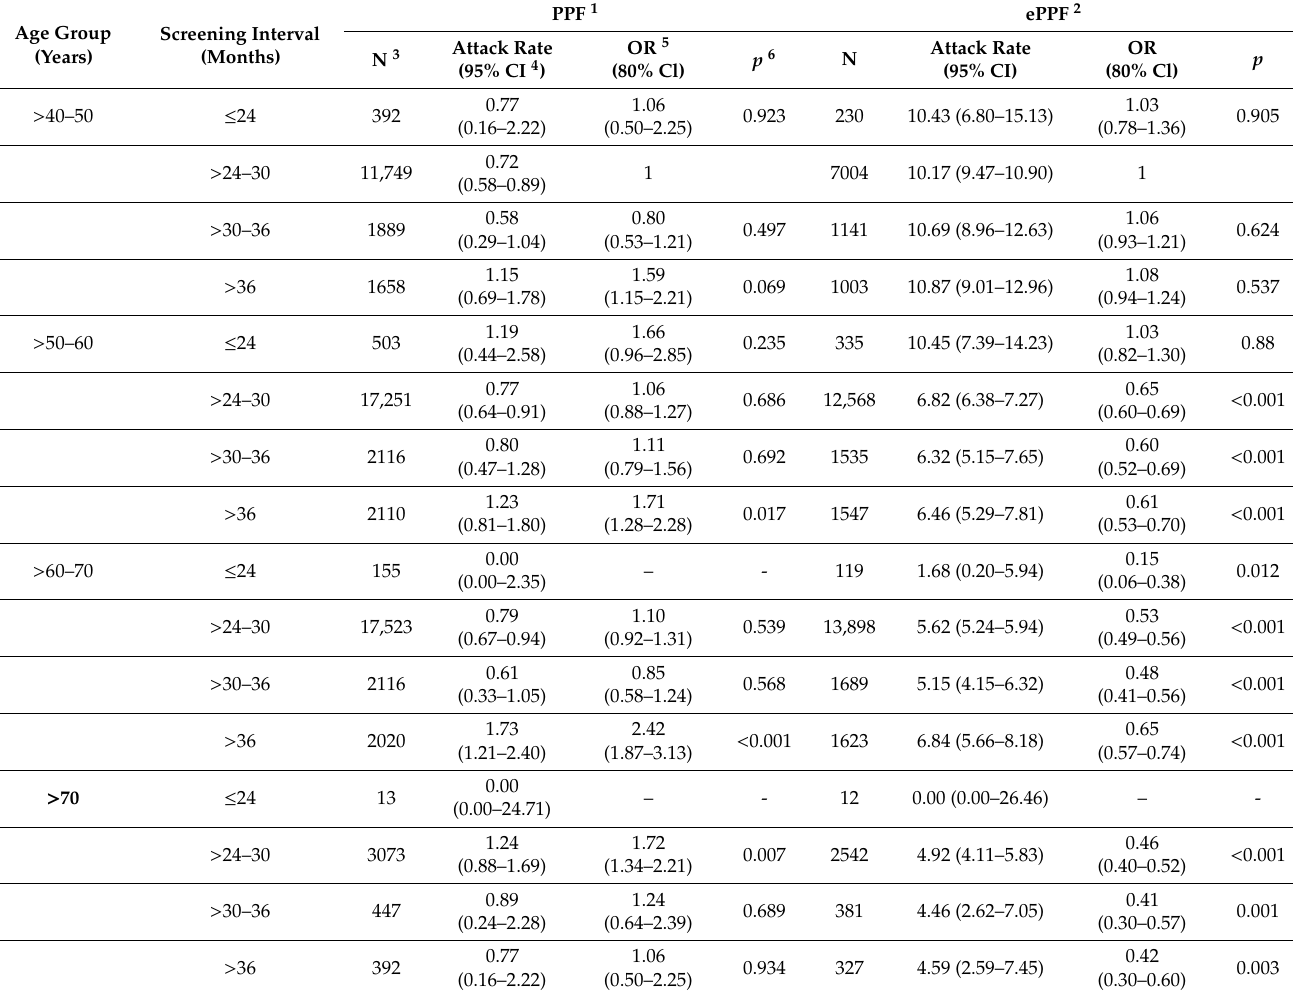
Table 3. Attack rates of PPFs and ePPFs and odds ratio to the reference group for each age and interval